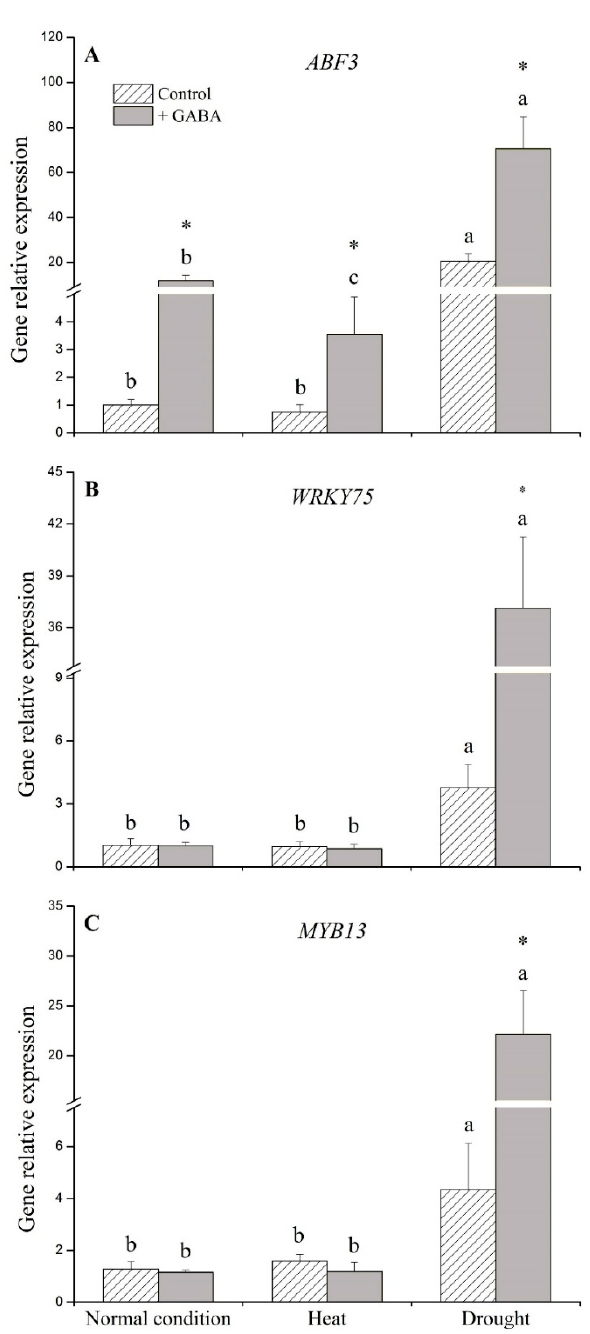
Figure 5. Effects of γ -aminobutyric acid (GABA) on genes’ expression of ( A ) ABF3 , ( B ) WRKY75 , and ( C ) MYB13 transcription factors under normal, heat, and drought conditions. Vertical bars indicate ± SE of mean ( n = 4). Different letters above columns indicate significant differences for one particular treatment (control or +GABA) under different conditions; asterisk “*” indicates significant difference between control and +GABA treatment under a given condition.